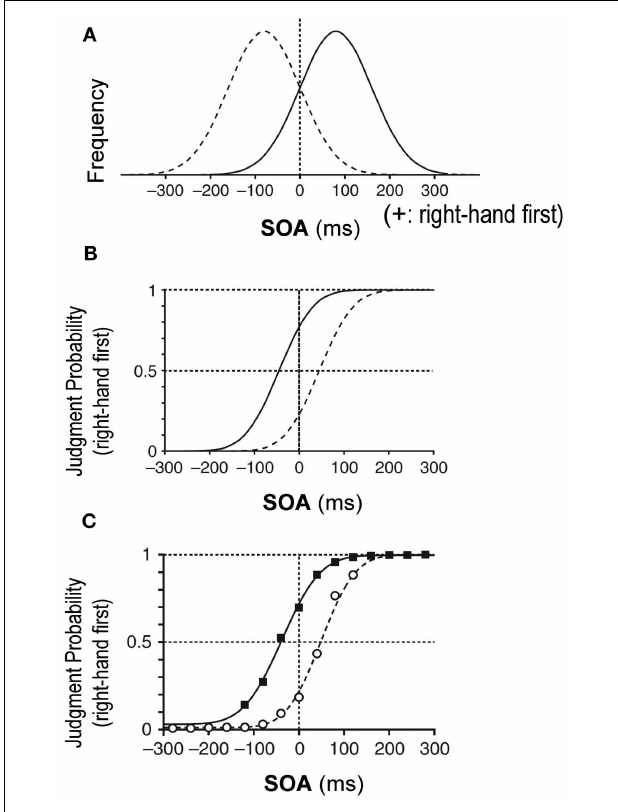
FIGURE 1 | Bayesian estimation in temporal order judgment (TOJ) of two tactile stimuli, one delivered to each hand (Miyazaki et al., 2006). (A) Prior distributions of stimulus-onset asynchrony (SOA) of the two stimuli. On the x -axis, positive SOA values signify that the right hand was FIGURE 2 | Overview of the experimental setup. A seated participant stimulated before the left, and negative values signify that the left hand was placed the pads of both index fingers on a pair of piezoelectric skin contacts stimulated first.The y -axis is the SOA frequency.The solid Gaussian has a (A) .The contacts delivered brief mechanical pulses, one to each hand. mean ( µ prior ) of + 80ms and a SD ( σ prior ) of 80ms. Given this prior, subjects White noise was played through headphones placed over the participants’ were exposed to stimulus pairs with the right hand stimulated first in plugged ears to shut out sounds and ensure only tactile sensations from ∼ 84% of trials. Conversely, the dashed Gaussian ( µ =− 80ms, the contacts. Participants reported the side of the first stimulus by pressing prior σ = 80ms) shows that subjects were exposed to stimulus pairs with the one of two foot pedals corresponding to the stimulated side. A two-color prior left hand earlier in ∼ 84% of trials. (B) Predictions of theTOJ responses by LED (central LED) placed in front of the participants’ eyes ( ∼ 40cm away) the Bayesian estimation model.The psychometric functions shift away from was illuminated (red or green) 1s before the tactile stimuli in each trial. peaks of the prior distributions. (C) Experimental observation for the tactile Participants opened their eyes and viewed the LED, but boards placed TOJ.The psychometric functions of the subjects’ responses were in between their eyes and hands prevented them from viewing their accordance with the Bayesian estimation model. hands (B)